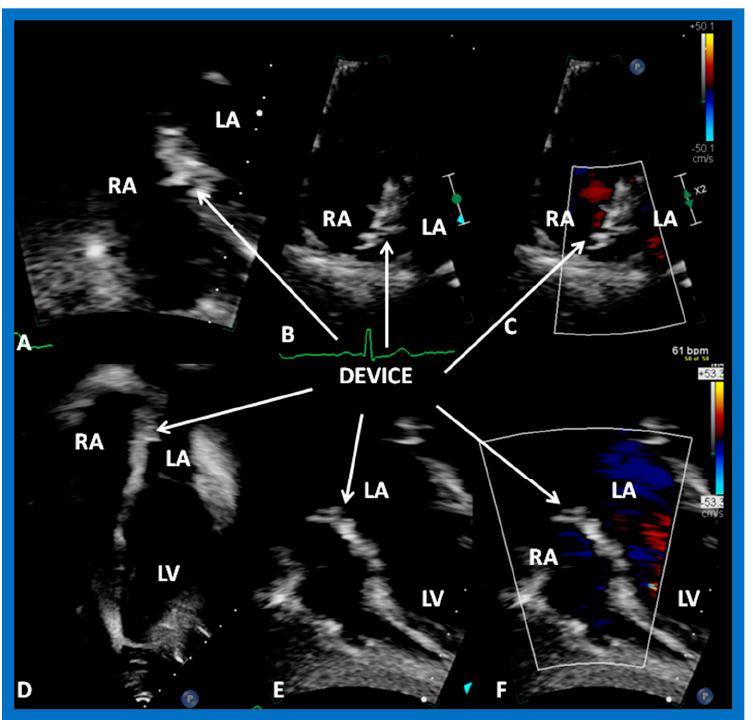
Figure 41. Selected video frames from subcostal ( A , E , F ) and apical four-chamber ( B – D ) transthoracic echo views of the atrial septum, demonstrating GORE ® CARDIOFORM ASD Occluder device across the atrial septal defect three months after the device implantation. Good location of the device (DEVICE) without residual left-to-right shunt ( C , F ) is shown. LA, left atrium; LV, left ventricle; RA, right atrium.